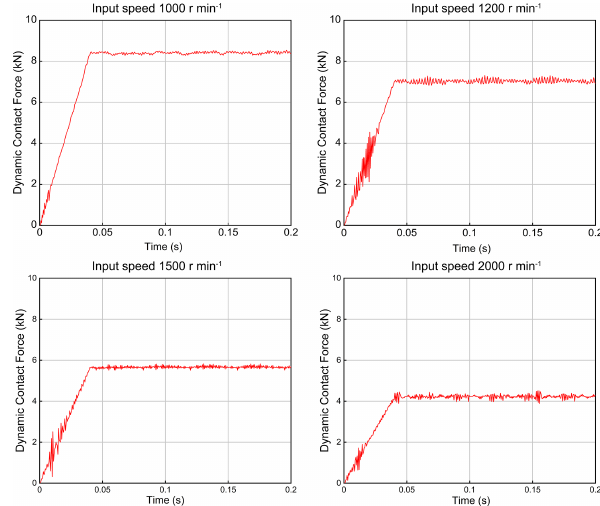
Figure 14. Dynamic meshing force under different input speeds.